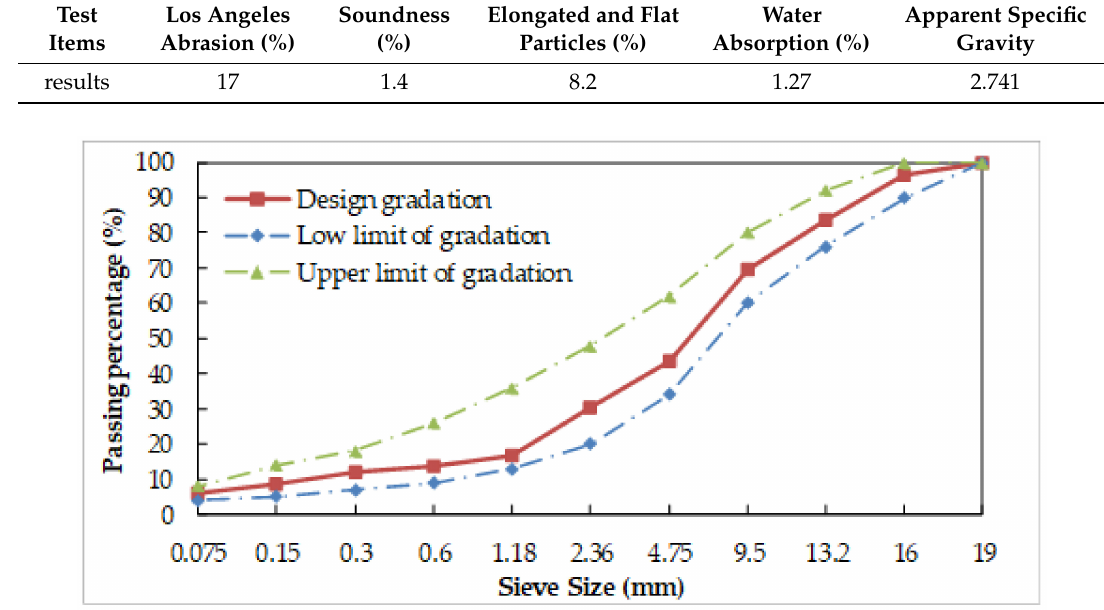
Figure 1. AC-16 aggregate gradation curve. Table 2. Basic physical properties of the asphalt.